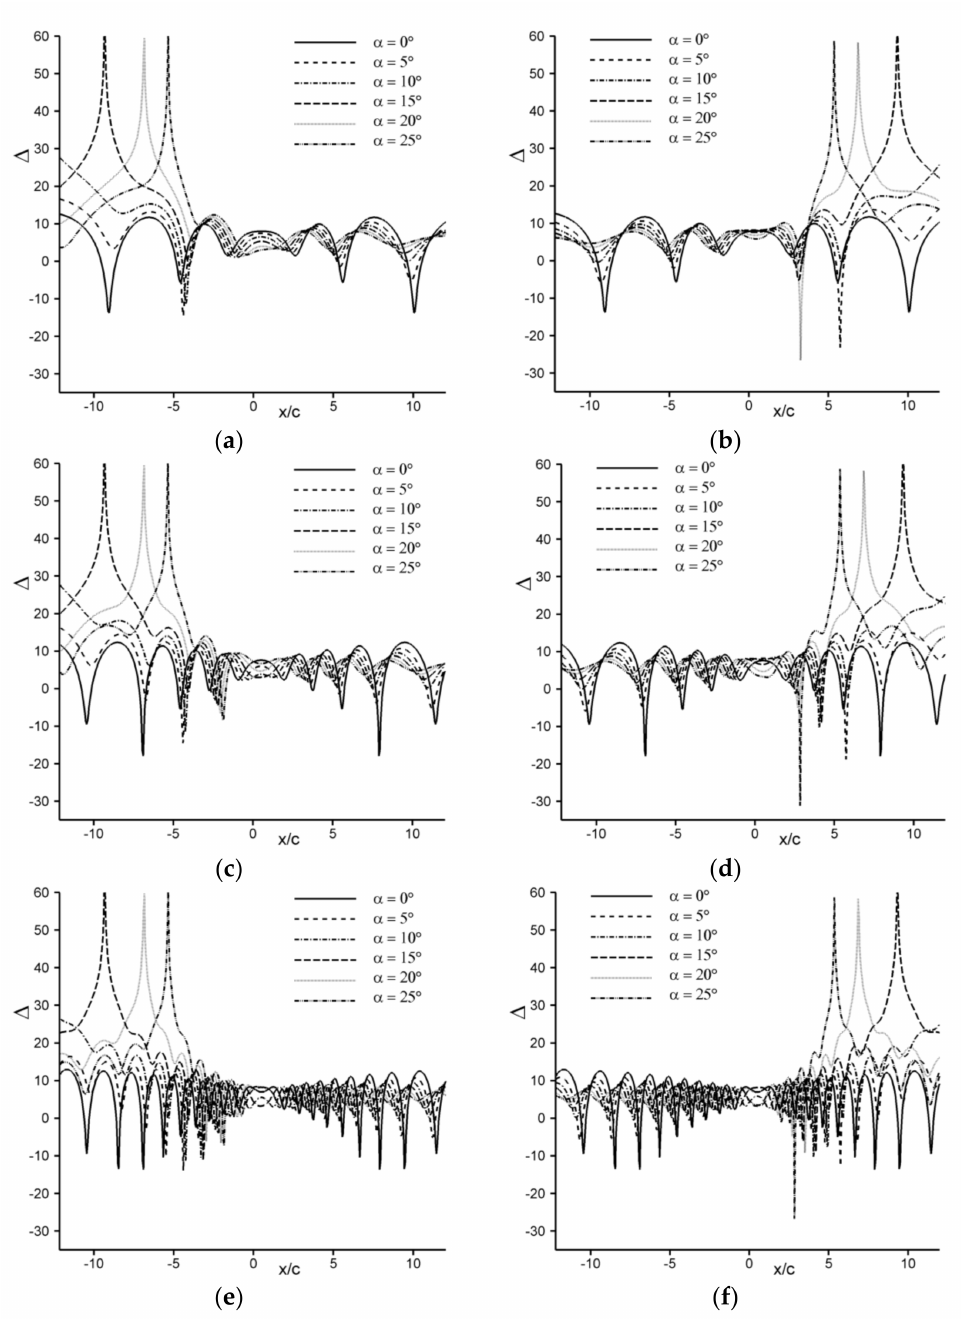
Figure 10. Moderate to high frequency ( St = 0.882, 1.47, 2.94) noise radiation from the trailing edge of an airfoil set at low to high incidences ( α = 0 ◦ , 5 ◦ , 10 ◦ , 15 ◦ , 20 ◦ , 25 ◦ ). From top to bottom: St = 0.882 ( a , b ), St = 1.47 ( c , d ), St = 2.94 ( e , f ). Deltas (in dB) between the incident and total RMS pressure fields, as recorded along the top (left: a , c , e ) and bottom (right: b , d , f )